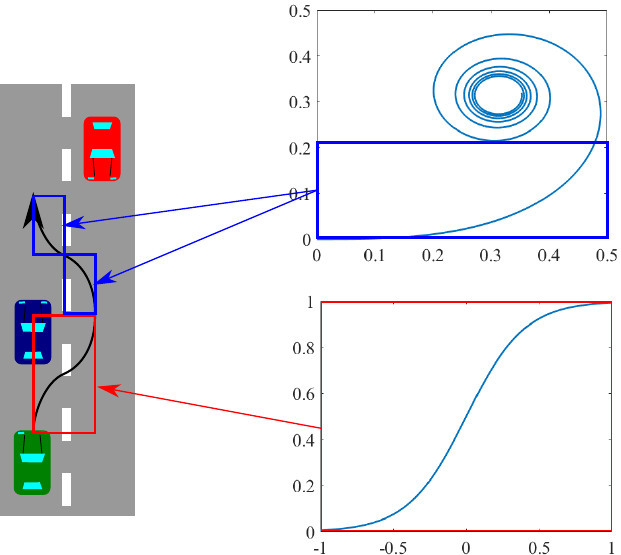
Figure 3. The driving path of overtaking and the two types of curves for